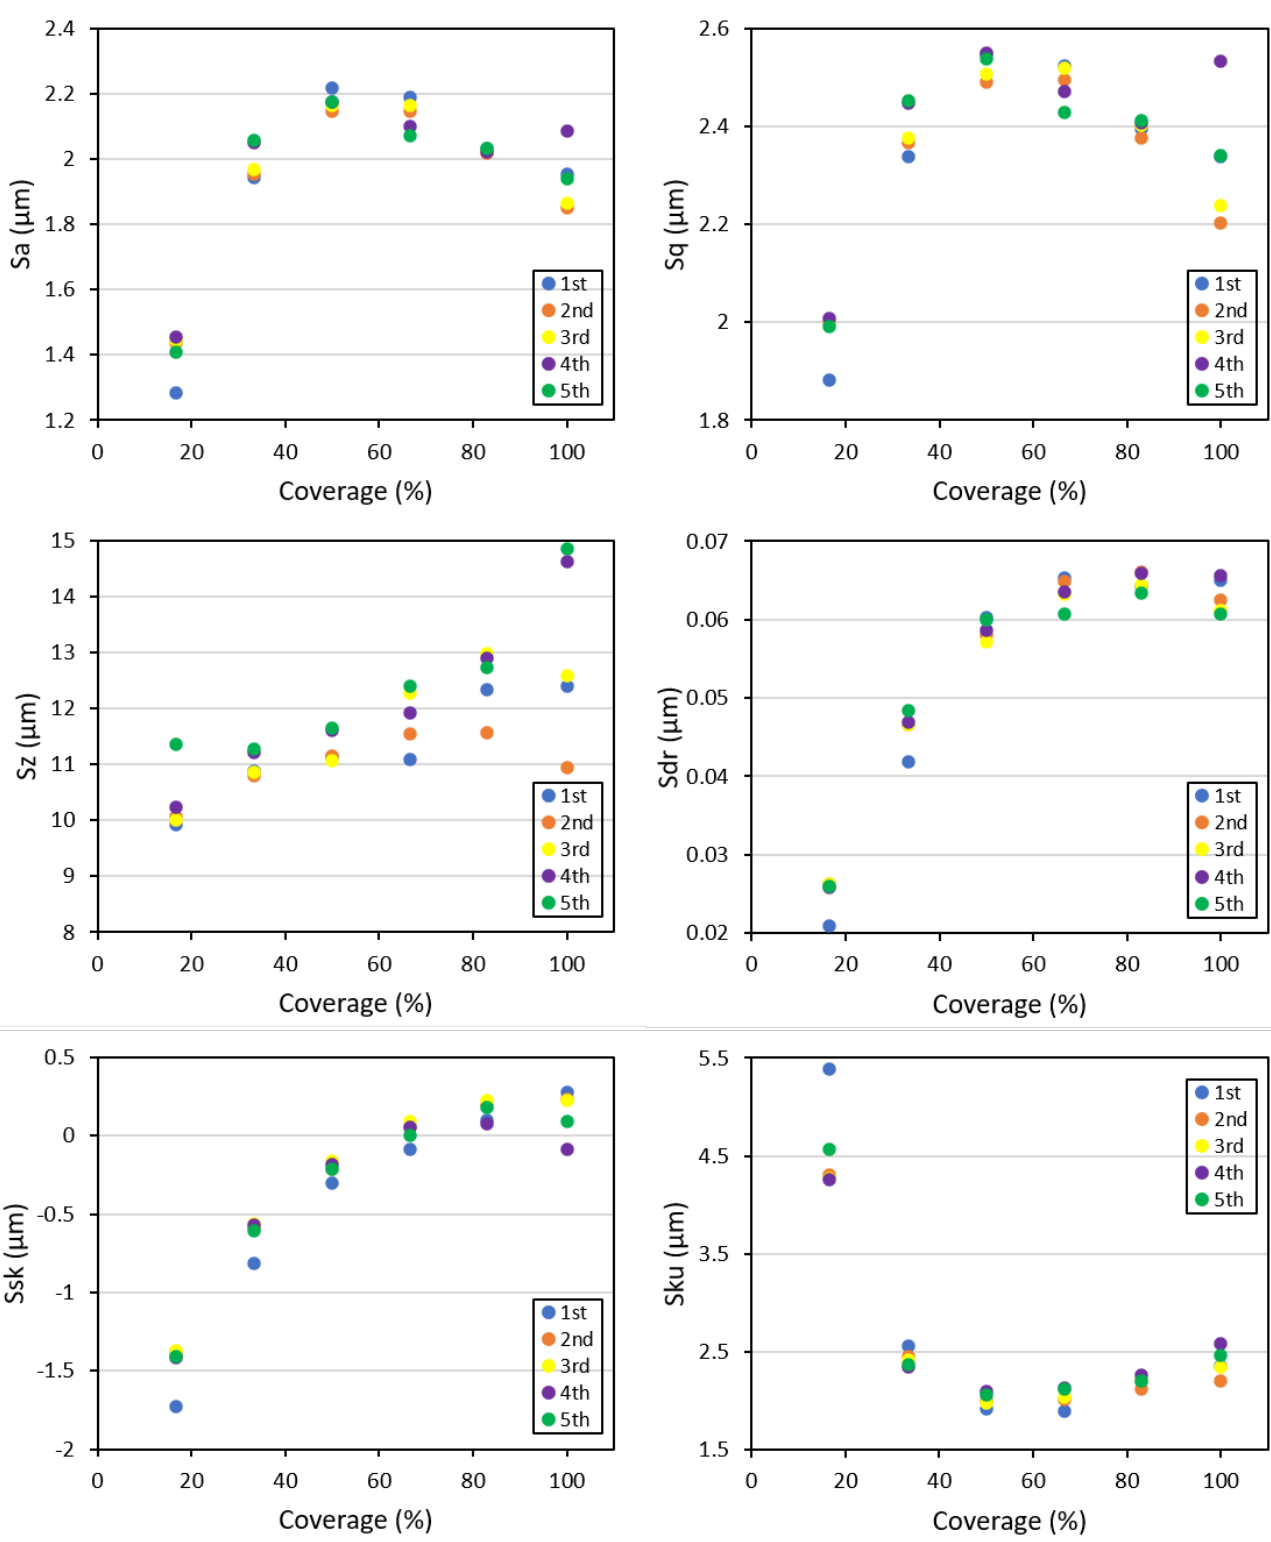
Figure 5. Evolution of select areal parameters as a function of surface coverage in the numerical simulations.